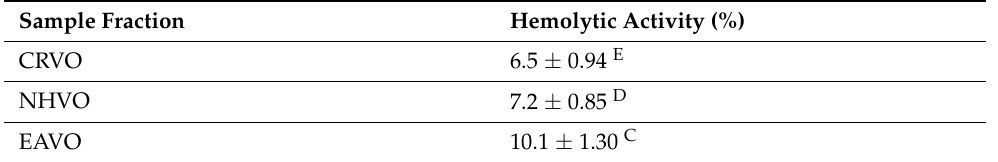
Table 3. Hemolytic potential of crude methanolic extract (CRVO) and different fractions ( n -hexane extract (NHVO), ethyl acetate extract (EAVO) and n -butanol extract (NBVO)) of Verbena officinalis